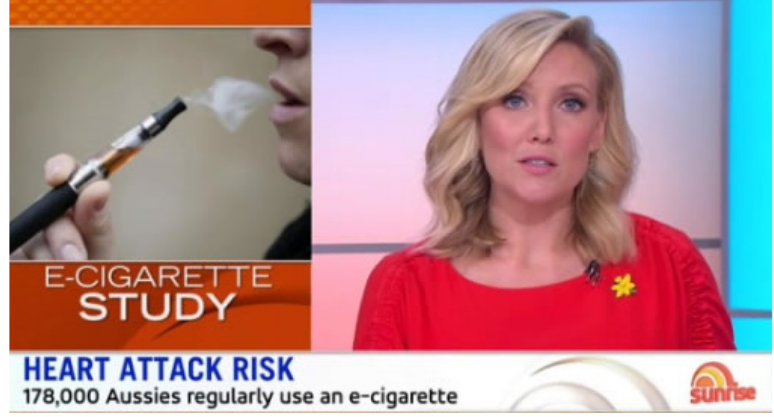
Figure 4. Example of health consequences being explained within the “health, safety, and product claims” domain.